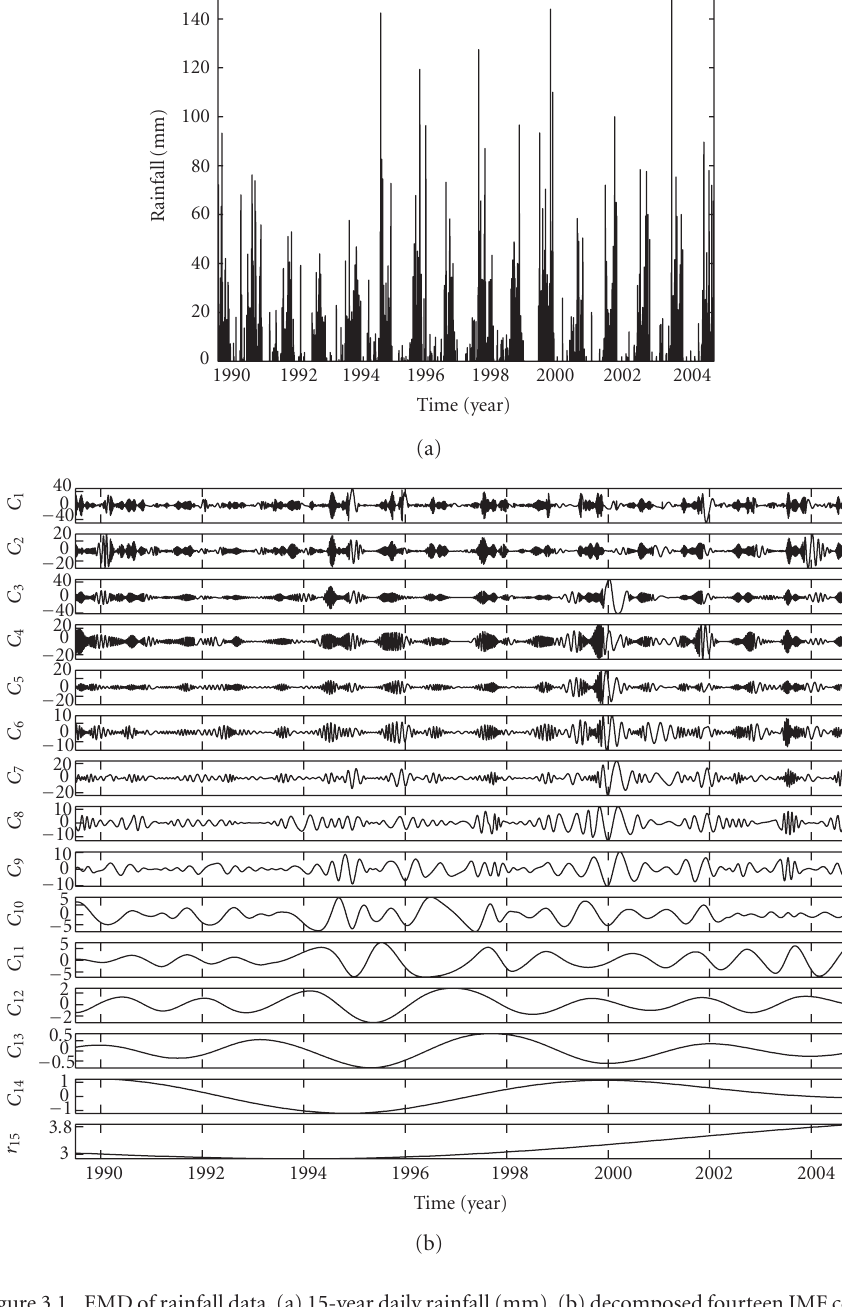
Figure 3.1. EMD of rainfall data, (a) 15-year daily rainfall (mm), (b) decomposed fourteen IMF com- ponents and the final